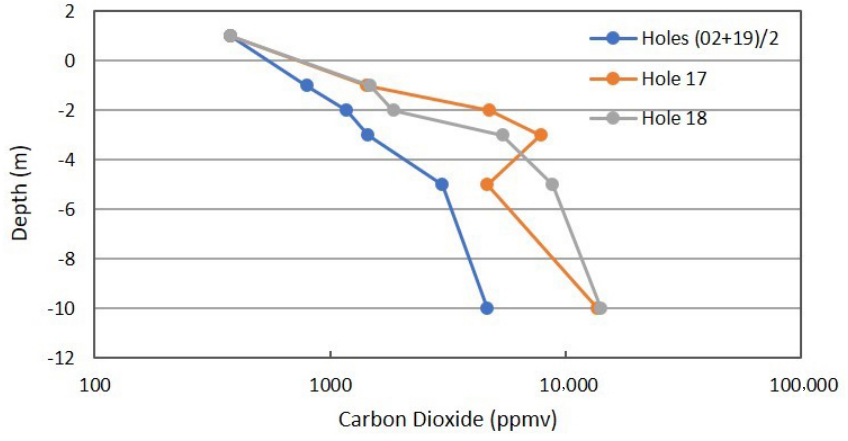
Figure 9. Carbon dioxide profile in combined background locations and Locations 17 and 18 in Fault Zone 2. See Figure 5 for the